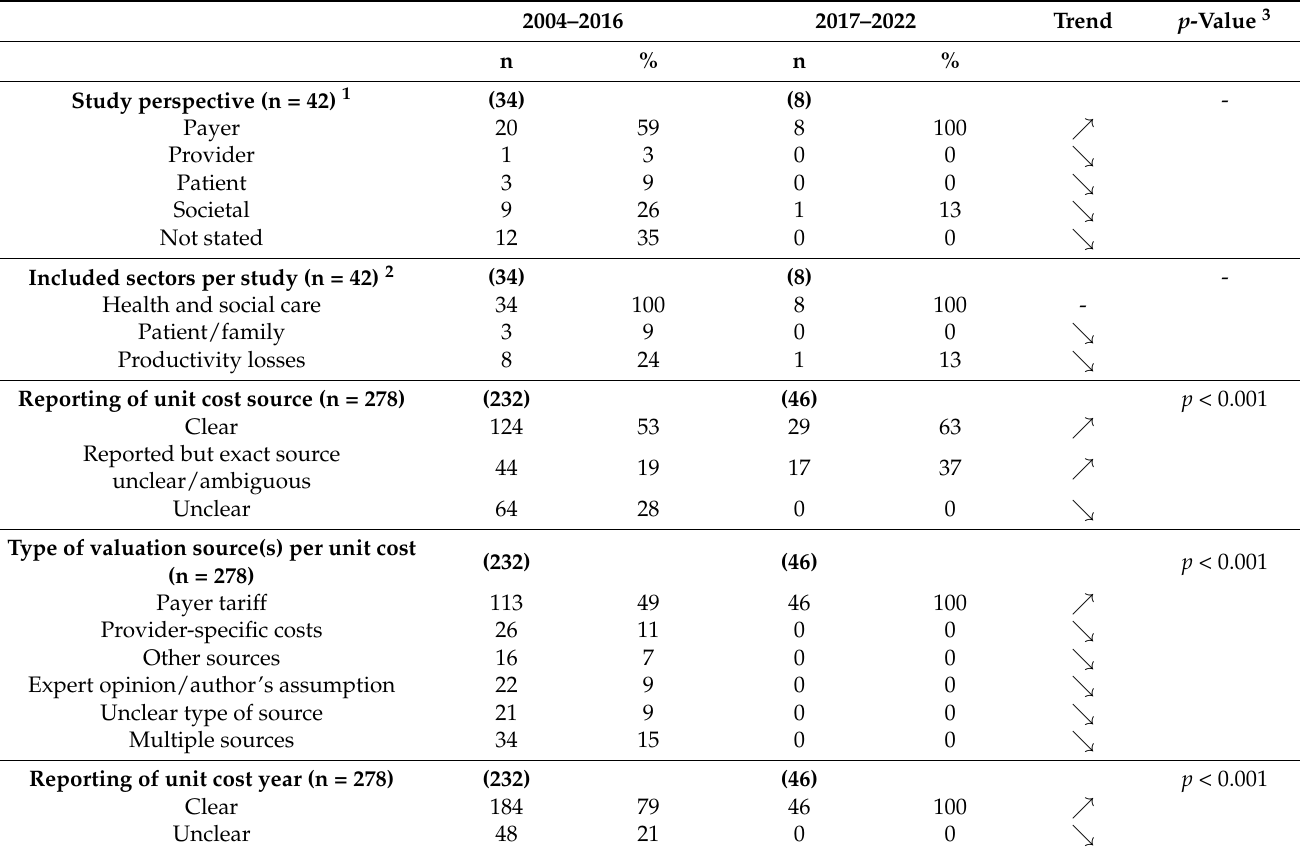
Table 2. Unit costing methods and reporting (n = 42 on study level, n = 278 on unit cost